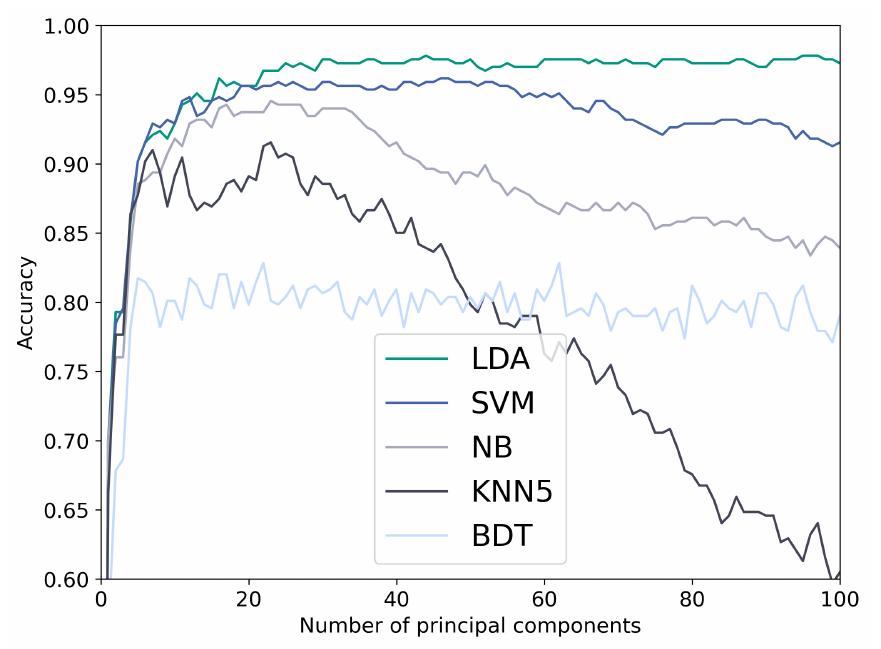
Figure 3. Accuracy as a function of the number of principal components used for the nonrigid iterative closest points affine (N-ICP-A) classifier.